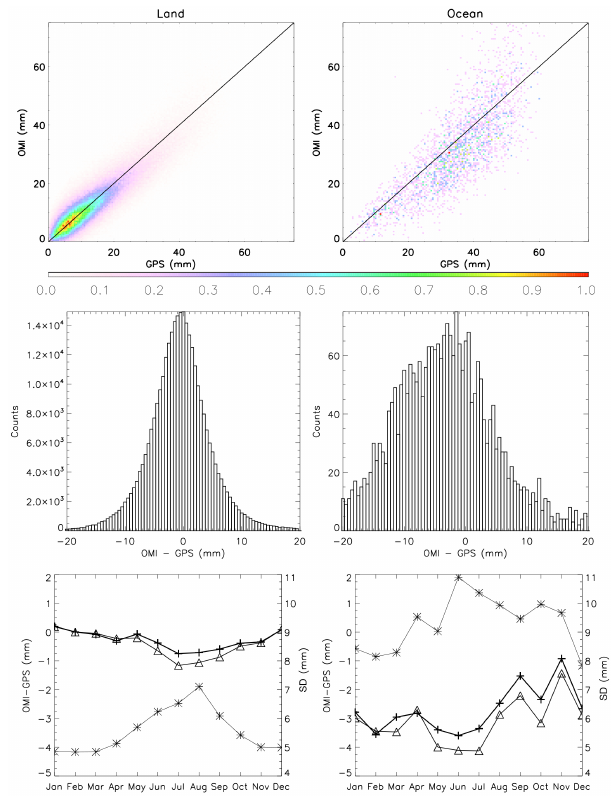
Figure 4. Top: 2-D normalized histograms for (left) land and (ocean) derived from all the paired version 1.0 OMI and GPS data at all suitable IGS-SuomiNet stations from 1 January 2005 to 31 De- cember 2009. Results are shown for 0.5mm × 0.5mm bins, with the largest binned value normalized to 1. The black line in each panel corresponds to 1:1. Middle: histograms of OMI − GPS derived from the same data as those used in the top panel. The counts correspond to 0.5mm bins. Bottom: median (triangle, left axis), mean (cross, right axis), and standard deviation (star, right axis) of version 1.0 OMI − GPS as functions of